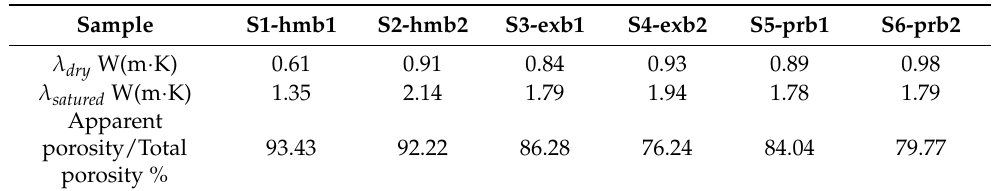
Table 5. Dry and saturated conductivity of the samples, test results, and ratio between the apparent and real porosity of the bricks used to make the samples.